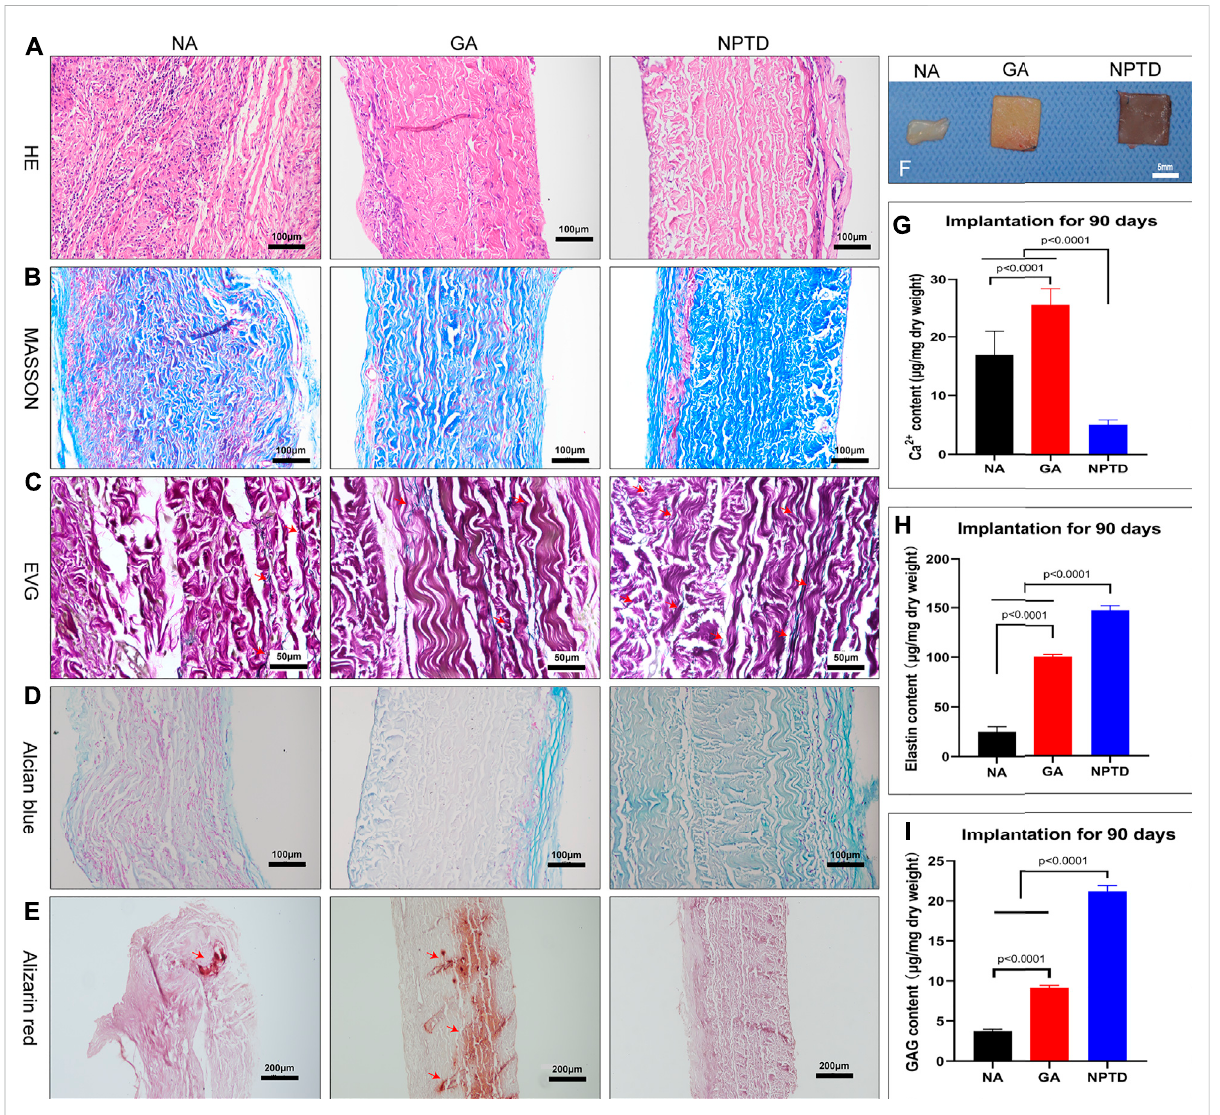
FIGURE 9 The grossspecimens,Histological characteristicsand quantitative analysis after subcutaneous implantation for 90 days. Thepericardiuminthe NA group was severely degraded in vivo , while the pericardium in the GA and NPTD groups was well preserved (F) . The images show the HE staining (A) , Masson ’ s trichrome staining (B) , elastic Van-Gieson staining (C) and Alcian blue staining (D) , Red arrows depict the preserved elastic fi bers. The Alizarin red staining show that the GA group had more calcium deposition than the NPTD group (E) , Red arrows depict the location of calci fi cation.ThecalciumquantitativeanalysisshowedthatthecalciumcontentoftheNPTDgroupwassigni fi cantlylowerthanthatoftheGAgroup (G) . The elastin and GAGs quantitative analysis showed that the preserved content of the NPTD group was signi fi cantly higher than that of the GA group (H,I) . Statistical analysis was performed by one-way analysis of variance